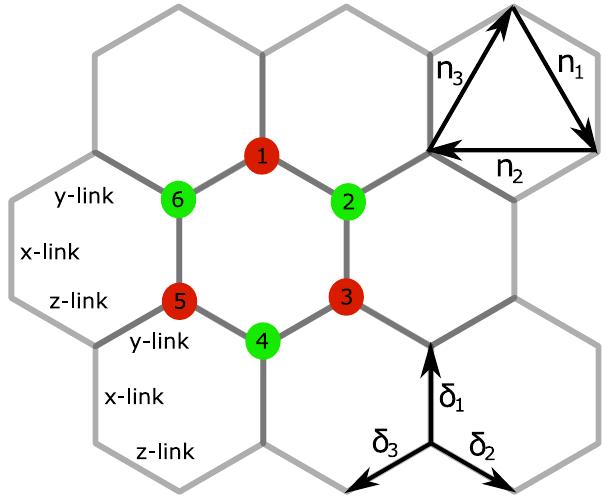
FIG. 3. The honeycomb lattice. Each unit cell is composed of an A (blue) and B (red) atom. Each atom in the A sublattice is connected to three B atoms via the vectors δ , and to six A atoms via the n vectors. The interaction between neighbors is deter- mined by the link they share. On each plaquette, the sites are labeled as